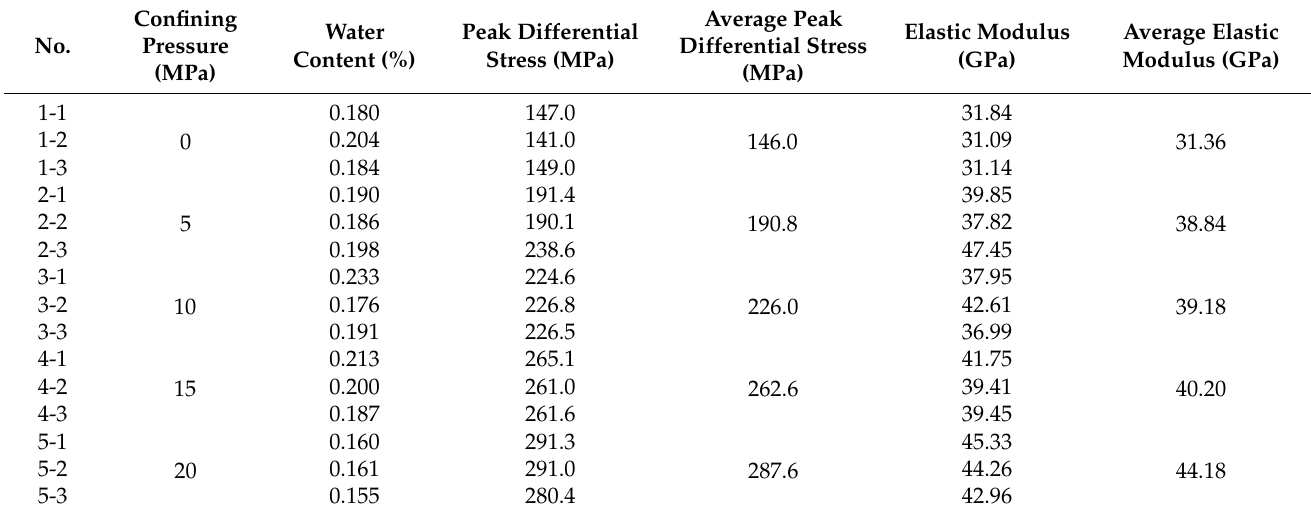
Table 1. The test results of granite with different confining pressures and water contents.